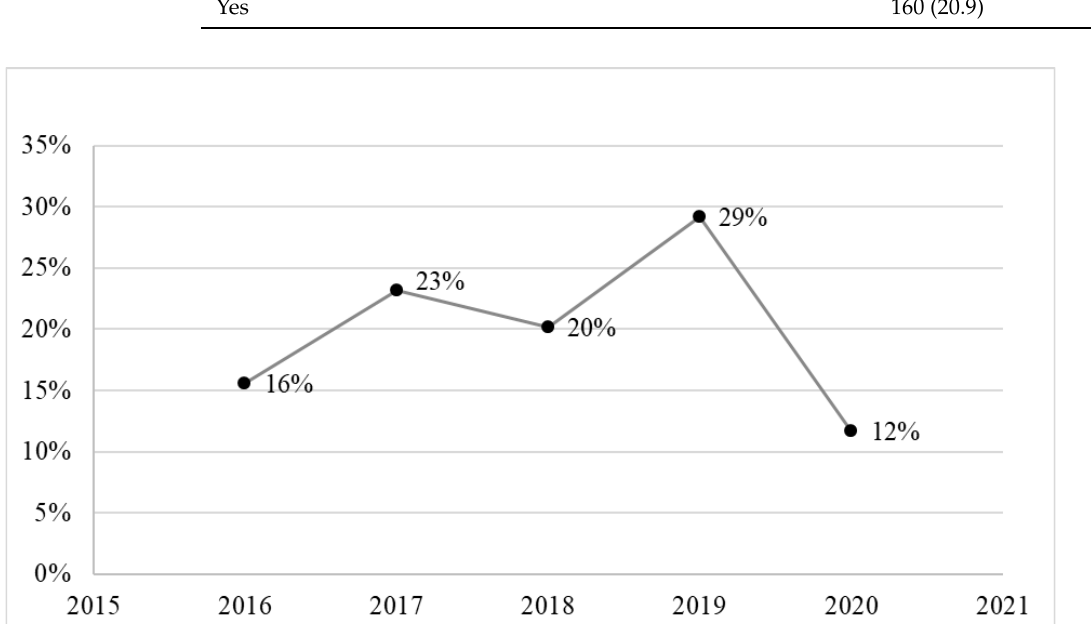
Figure 2. Distribution of subjects based on their state of residence.